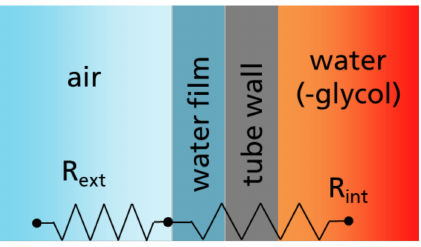
Figure 2. Schematic of the simplifications applied by the selected cooling tower model.